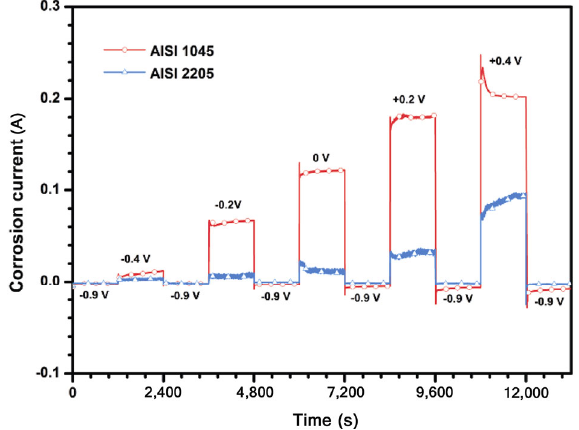
Fig. 7 Effect of applied potential on the corrosion current of AISI 1045 and AISI 2205 during sliding in seawater.